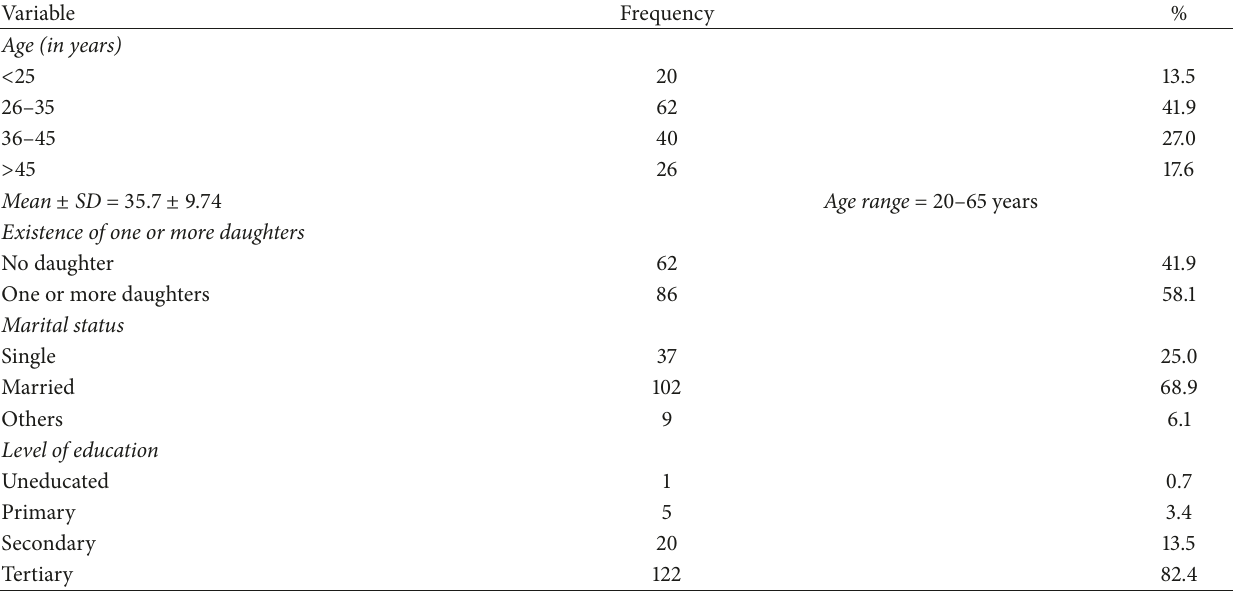
Table 1: Sociodemographic characteristics of respondents ( 𝑛 = 148 ).